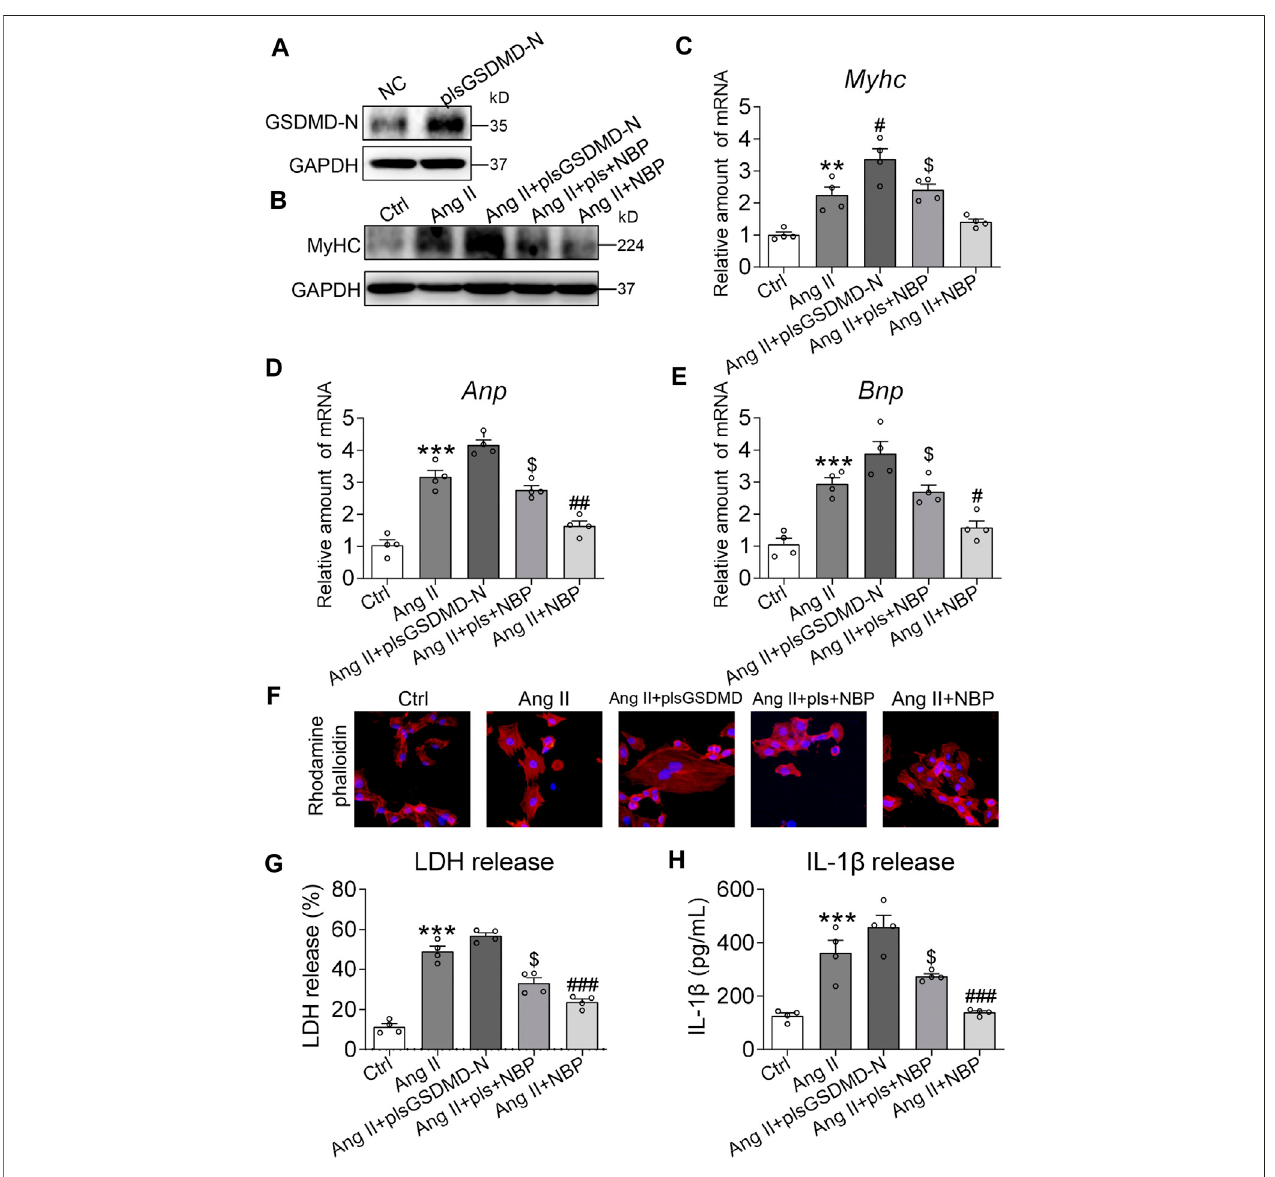
FIGURE 4 | Involvement of GSDMD in NBP-mediated cardiomyocyte protection. (A) Primary cardiomyocytes were transfected with cDNA plasmids encoding GSDMD-N (plsGSDMD-N) or empty vector (negative control, NC). Western blotting was performed to assess the protein levels of GSDMD. Primary cardiomyocytes transfectedwithNC or plsGSDMD-N werepretreatedwith NBP(20 μ m) for 1 h and then exposed toAng II(1 μ m) for theindicatedtimes. (B) AfterexposuretoAng IIfor 24 h, the effects of NBP and GSDMD-N overexpression on MyHC were detected by western blotting. (C – E) After exposure to Ang II for 12 h, the mRNA levels of Myhc, Anp, and Bnp were detected by RT-qPCR. (F) Rhodamine phalloidin staining of GSDMD-N-overexpressing primary cardiomyocytes (DAPI: nucleus; × 400 magni fi cation). (G – H) AfterexposuretoAngIIfor24 h,LDHandIL-1 β releaseweredetectedbyassaykits.(n (cid:1) 4ineachgroup;*,vs.Ctrlgroup;#,vs.AngIIgroup;$,vs. Ang II + NBP group; # and $ p < 0.05, ** and ## p < 0.01, *** and ### p < 0.001).